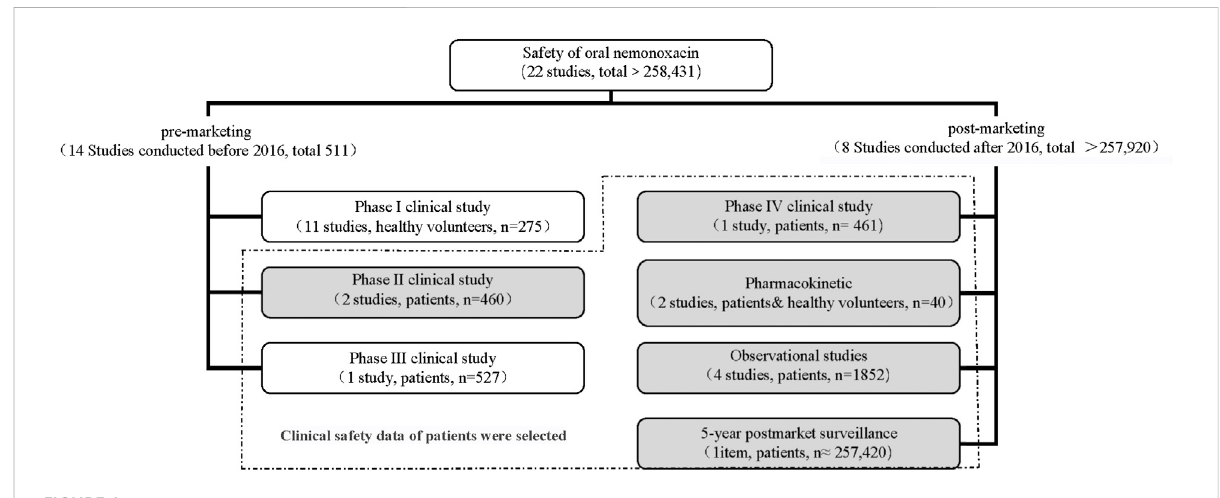
FIGURE 1 All safety results of oral